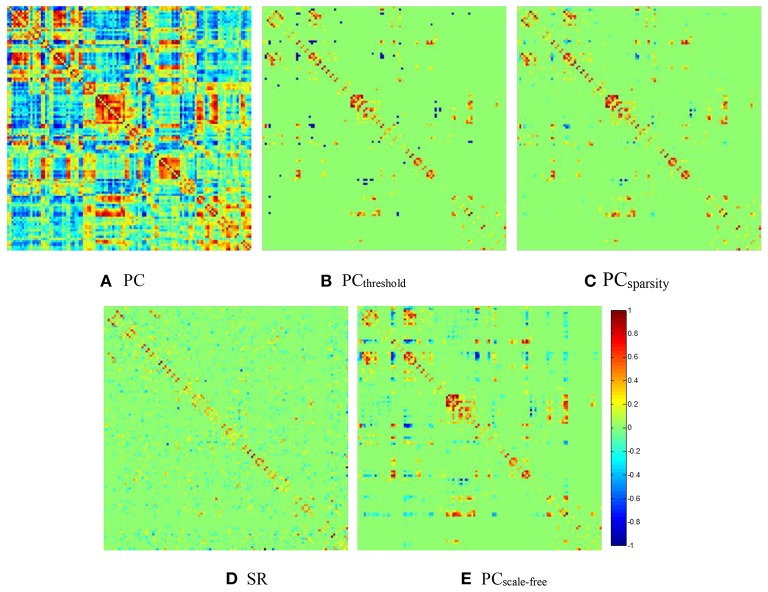
The FBN adjacency matrices of a certain subject, constructed by different methods. (A) PC, (B) PCthreshold, (C) PCsparsity, (D) SR, and (E) PCscale−free.